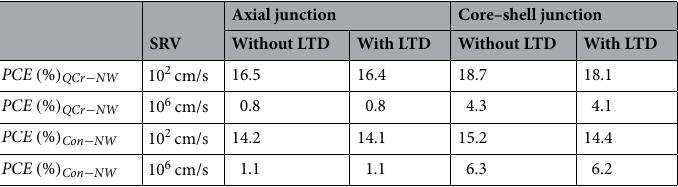
Table 8. The PCE of the conventional and proposed crescent structure in the axial and core–shell junctions with and without lifetime degradation under good and bad passivation.